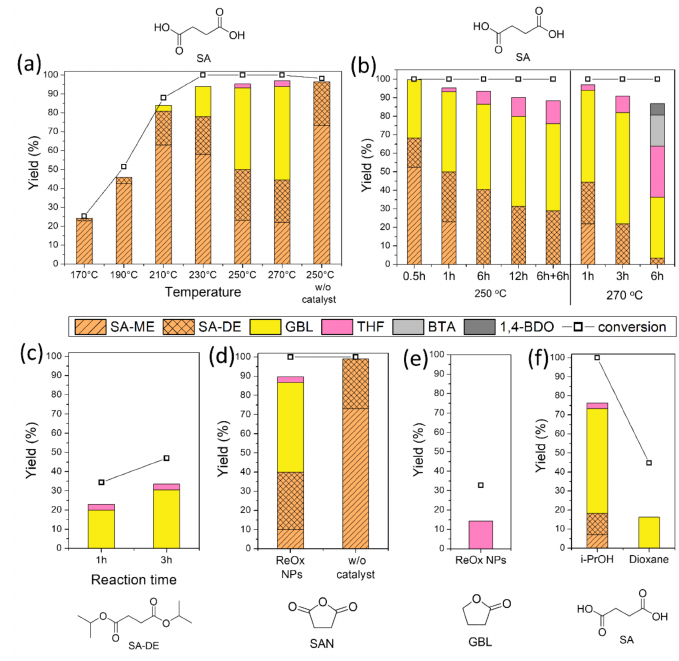
Figure 1. Conversion of succinic acid (SA), succinic anhydride (SAN), succinic acid diisopropyl